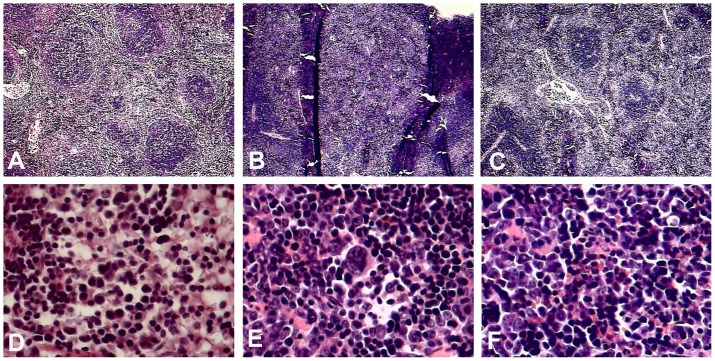
Histopathological analysis of spleen sections from AG129 mice under different experimental conditions.A, D. Untreated and uninfected control mice. B, E. Untreated infected mice. C, F. LOV-treated infected mice. A–C. Comparison between red and white pulp in spleen sections. In normal mice there was a conserved architecture of both pulps (A). In untreated infected mice, expansion of the red pulp was observed with depletion of the white pulp (B). In LOV-treated infected mice, a slight expansion of the red pulp was observed, but loss of the white pulp was not as severe as in untreated animals (C). D–F. Erythropoiesis comparison. In untreated infected mice, massive erythropoiesis was observed with megaloblastic changes (E). In normal mice (C) and treated mice (F), erythropoiesis was minor and no megaloblastic changes were observed.